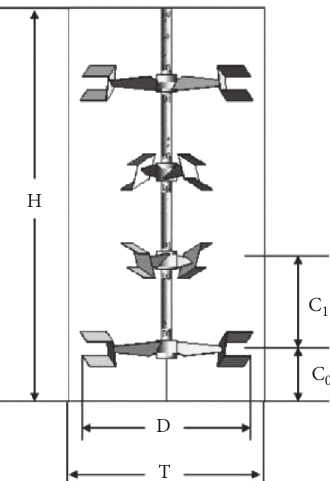
Figure 4: Geometry of the vessel equipped with four Intermig impellers